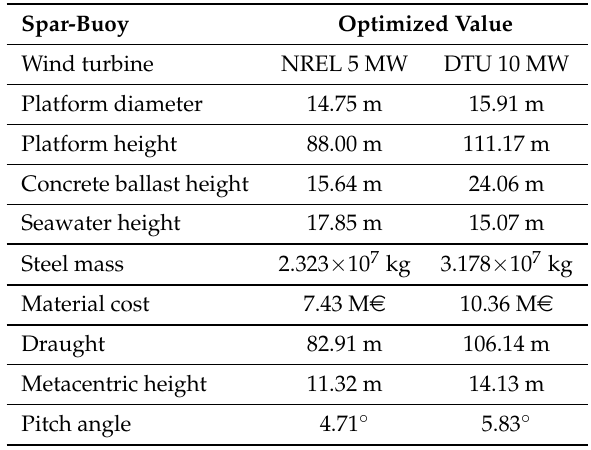
Table 3. Dimensions and main hydrostatic parameters for Spar-buoy design.